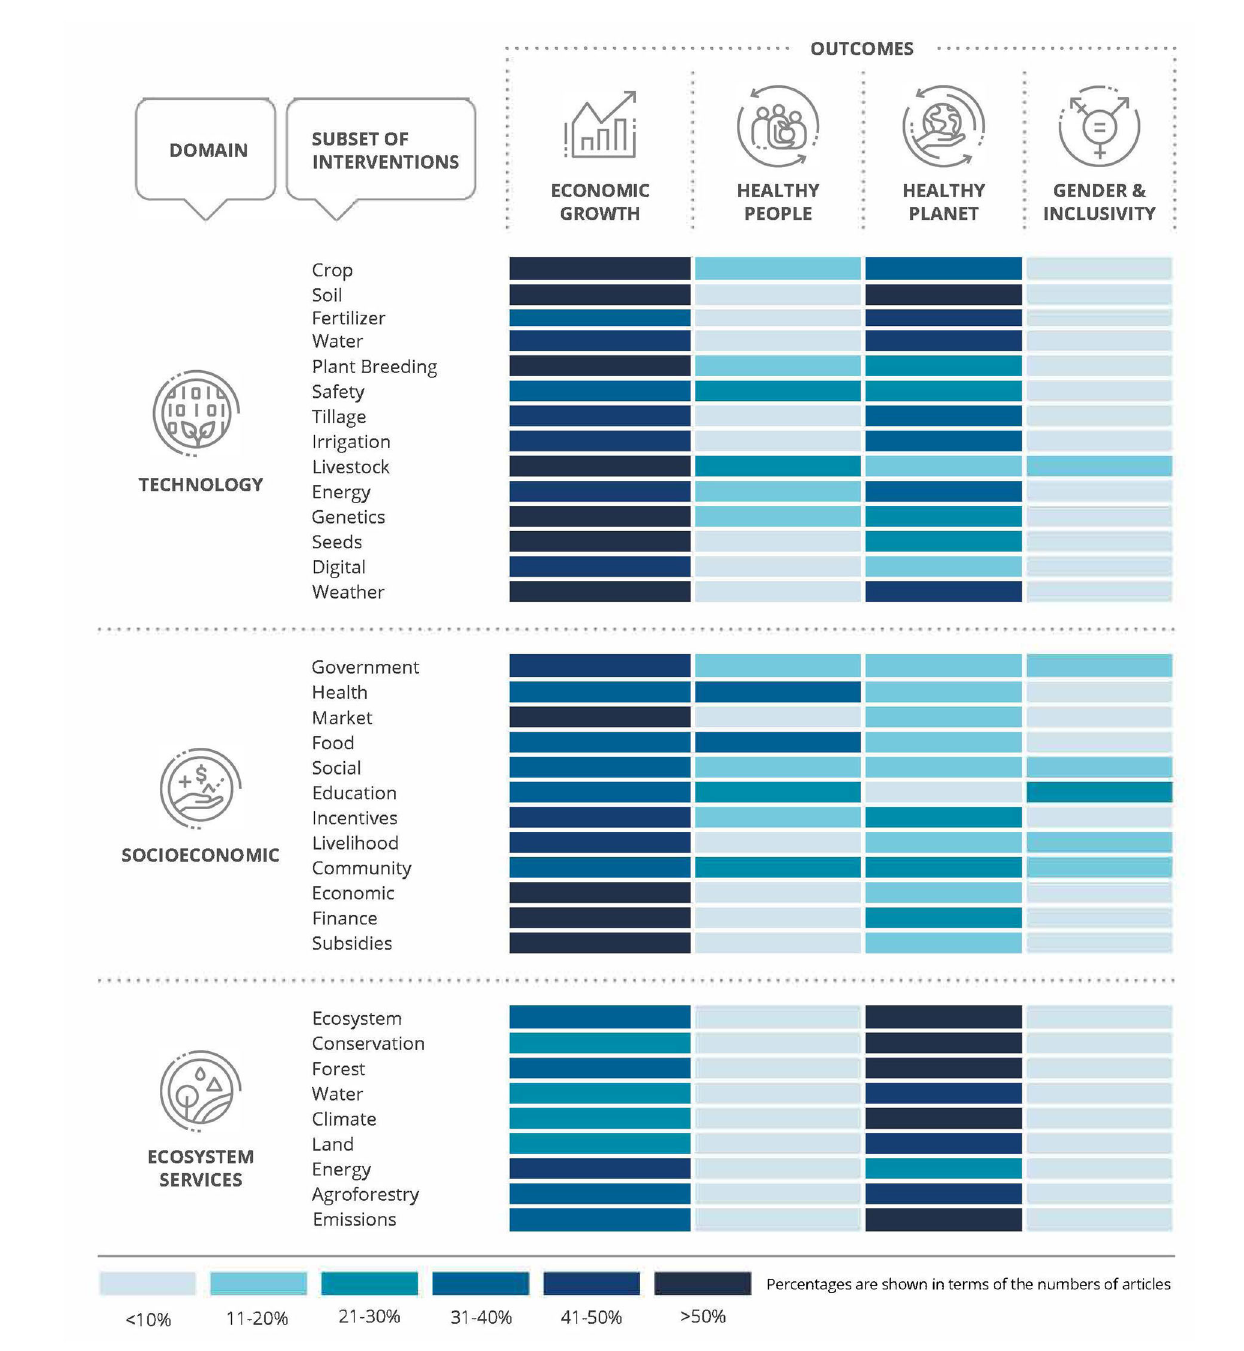
FIGURE2 An intervention and outcome evidence gap map identifying the most frequently studied interventions and associated